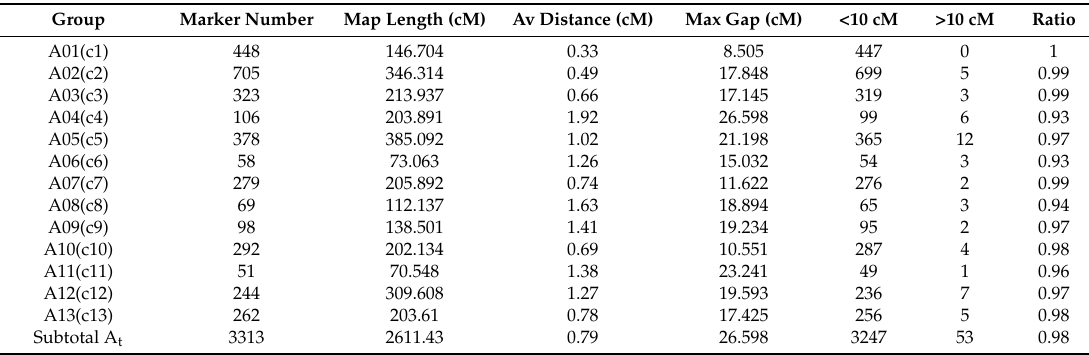
Figure 4. ( A ) Genetic linkage map constructed using the F 2:3 Population; ( B ) Plot of estimated recombination fractions of all markers used in the F 2:3 population. X and Y axis are the markers and Z is the linkage groups (LGs). Table 2. Genomic distributions of SNPs markers.